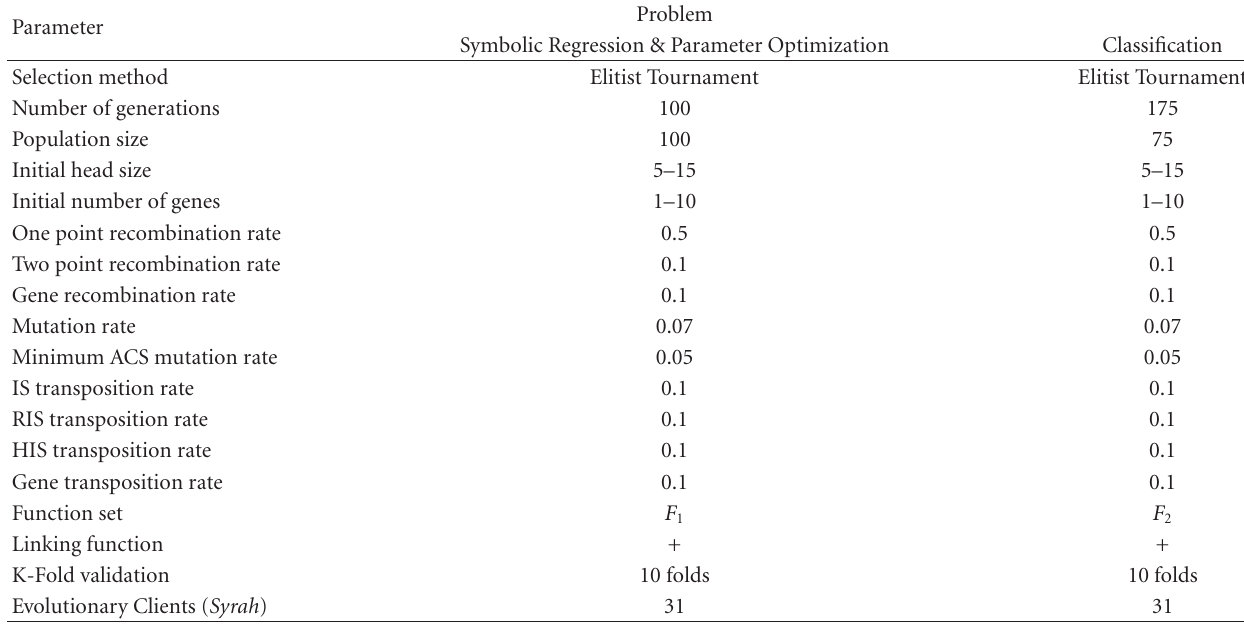
Table 1: Common experiment run